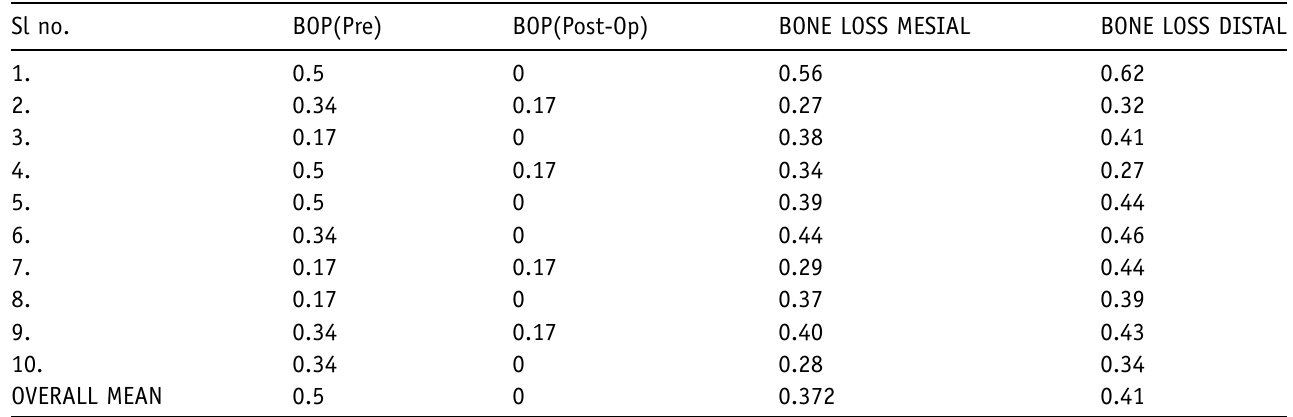
Table II. Showing BOP pre-op/post-op and radiographic bone loss mesial and distal sites. Sl